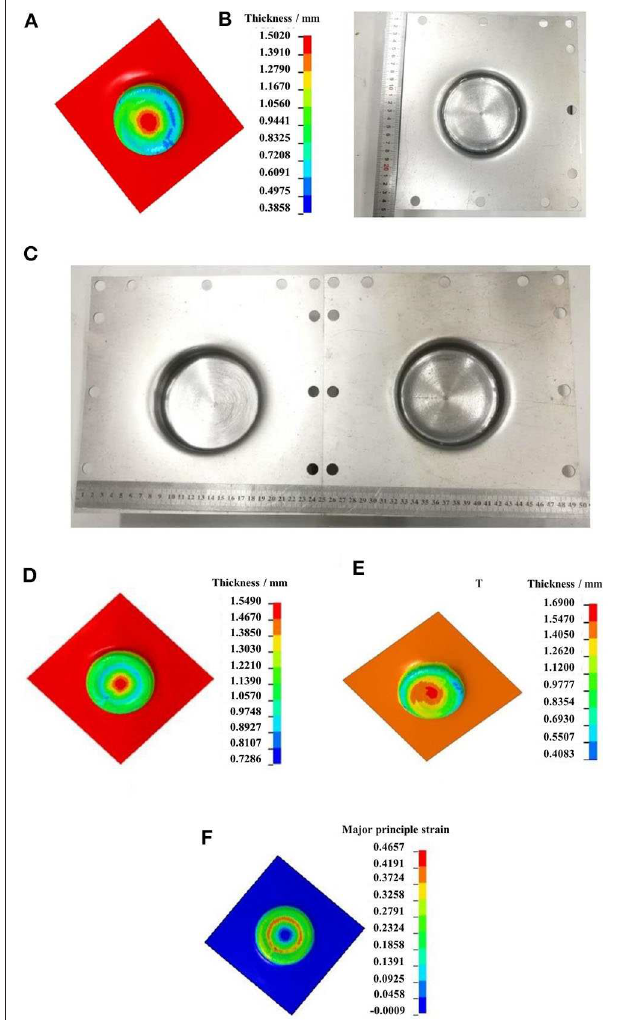
FIGURE 9 | The numerical simulated and experimental formed parts: (A) formed part by three-stage and four-stage SPIF; (B) the simulation result of the formed part by three-stage SPIF; (C) the experiment result of the formed part by three-stage and four-stage SPIF; (D) the simulated result by four-stages SPIF before optimization; (E) the optimal simulated result by four-stages SPIF; (F) the major principle strain distribution of the formed part in neutral layer.